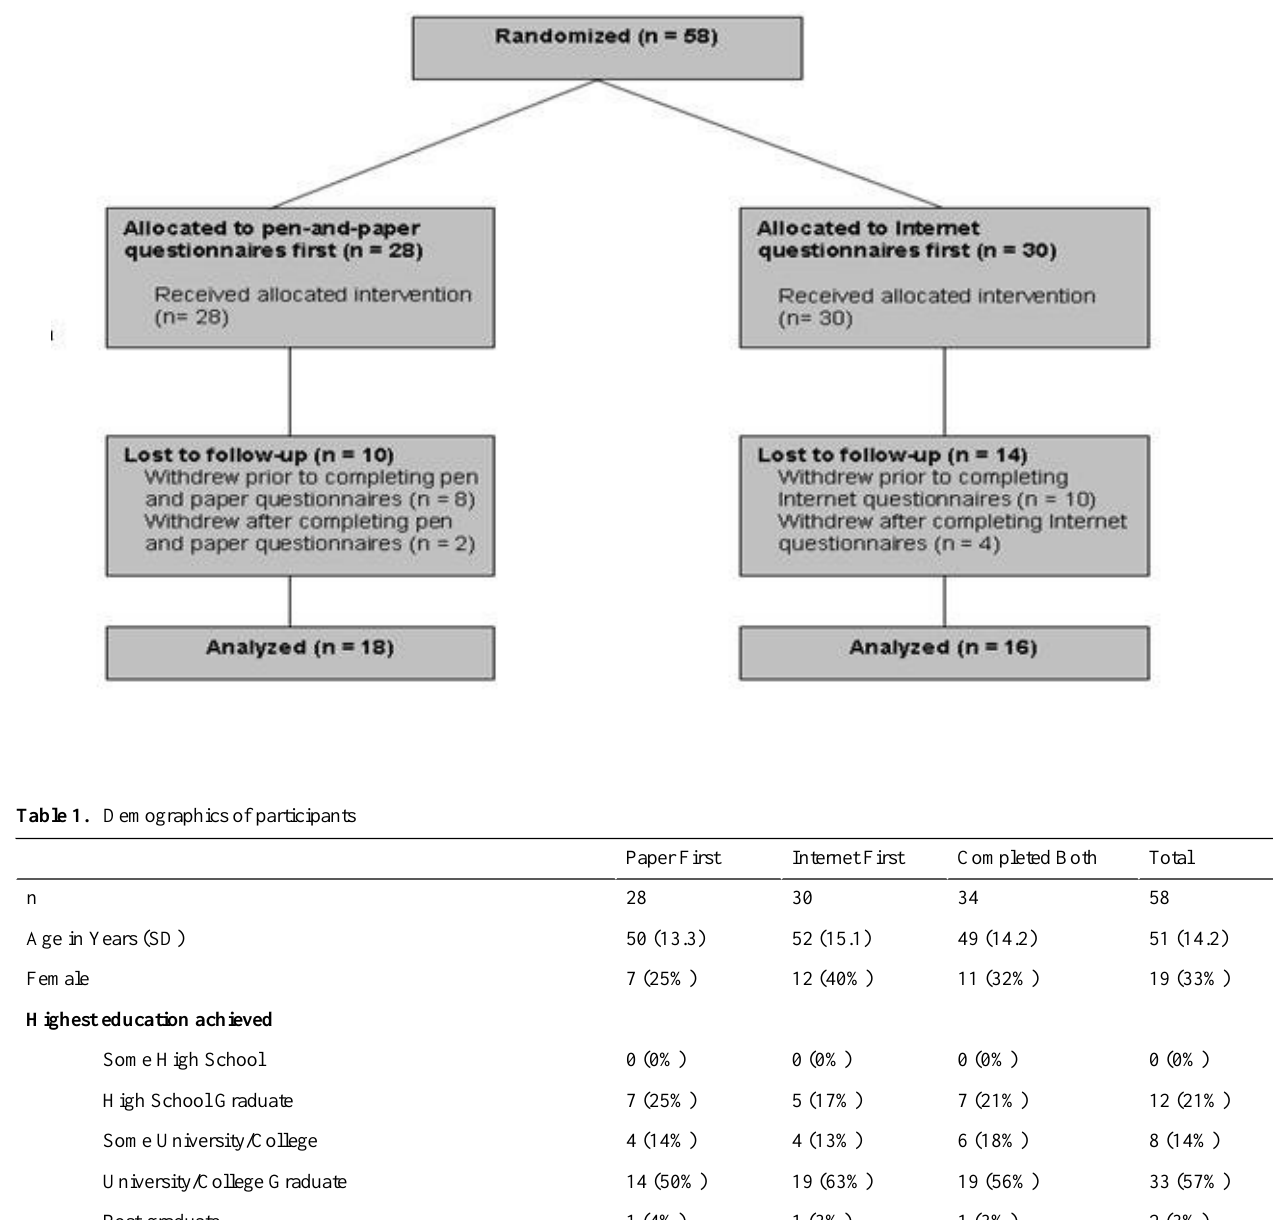
Figure 1. Flow of study participants